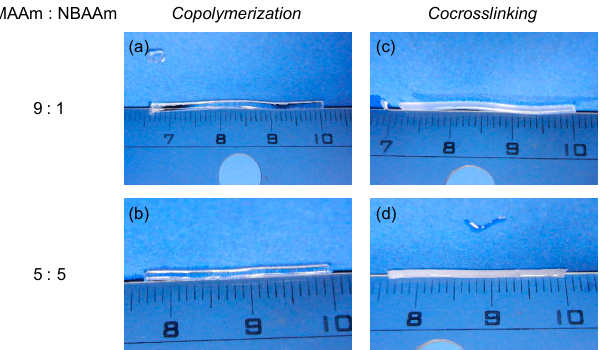
Figure 3. Appearance of ( a and b ) copolymerization and ( c and d ) co-crosslinking gels obtained from DMAAm and NBAAm with various monomer unit composition; DMAAm:NBAAm = ( a and c ) 9:1 and ( b and d ) 5:5.